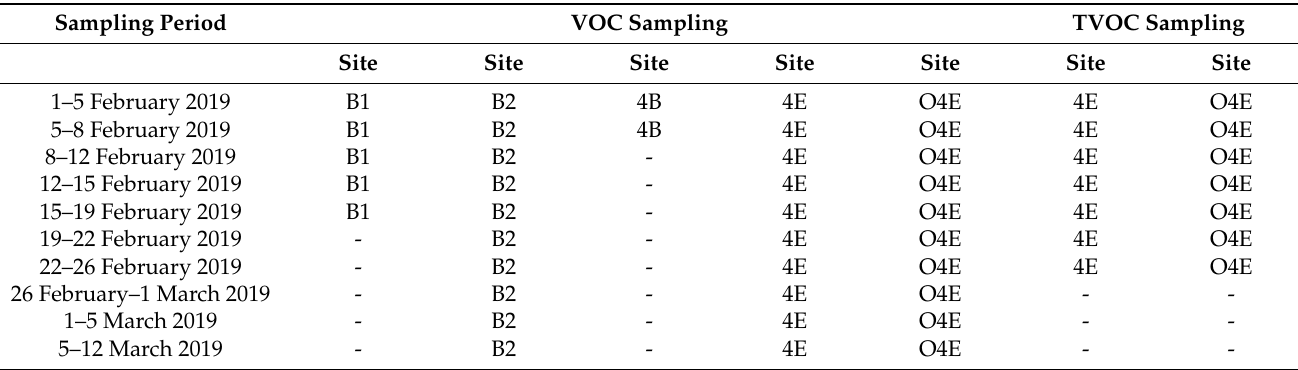
Table 1. Sampling time schedule in the different school places: B1 (male bathroom), B2 (female bathroom), 4B (classroom 4B), 4E (classroom 4E), and O4E (external balcony classroom 4E). Sampling